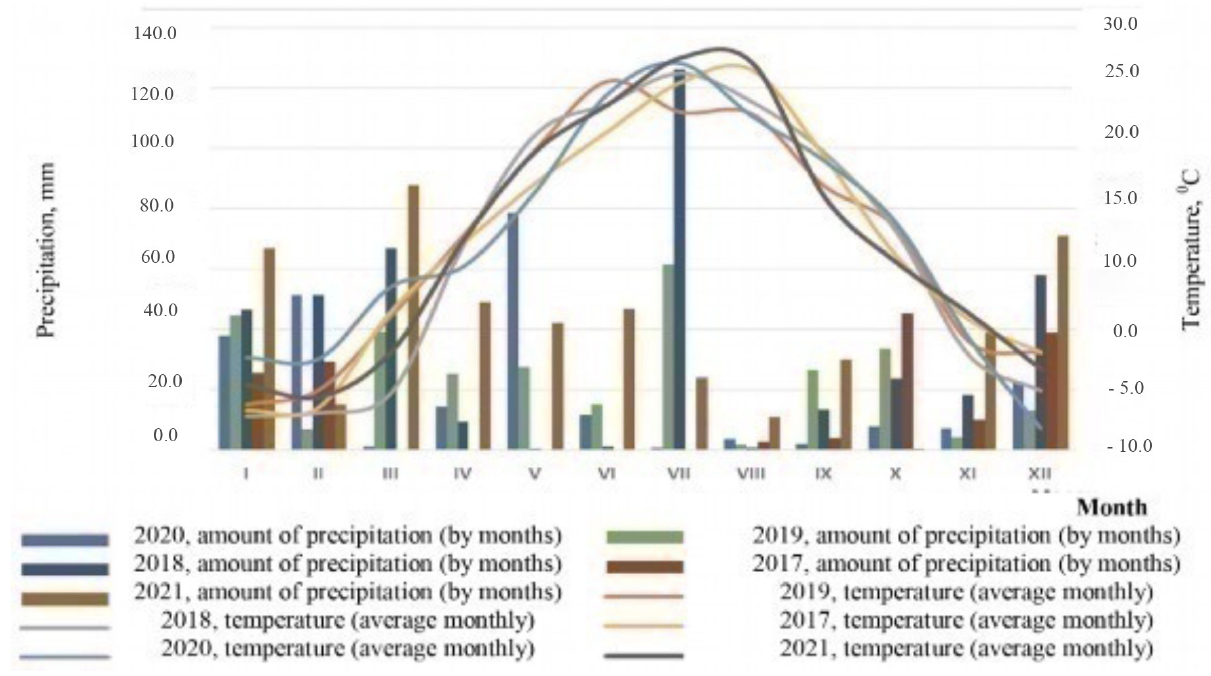
Figure 1. Climatogram of the research period (according to the weather station of Volgograd). These indicators are within two standard deviations ( σ = 1.24) from the average